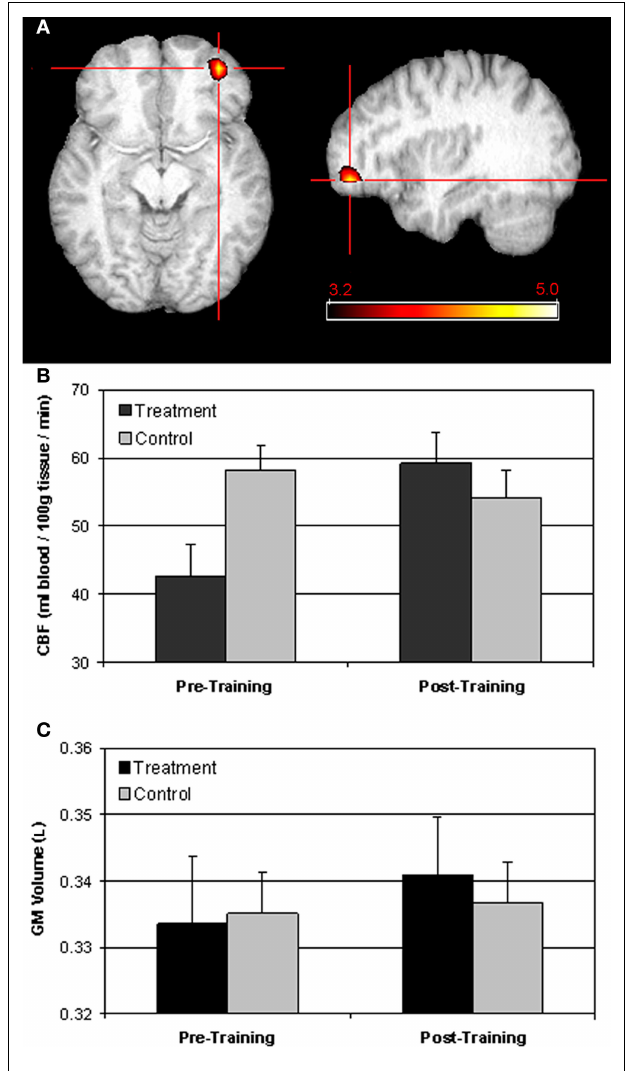
FIGURE 1 | Training-related changes in resting CBF. Whole-brain voxel-wise analysis of training-induced changes in CBF indicated that the treatment program produced larger increases in CBF to the right inferior prefrontal cortex than the control program (A) . Quantitative perfusion values extracted from the region shown in (A) increased from 43.6 to 59.2 ml/100 g/min for the treatment group and decreased slightly, from 58.1 to 54.2 ml/100 g/min for the control group (B) . There were no signifi cant changes in GM volume in this region for either the treatment group or controls (C)